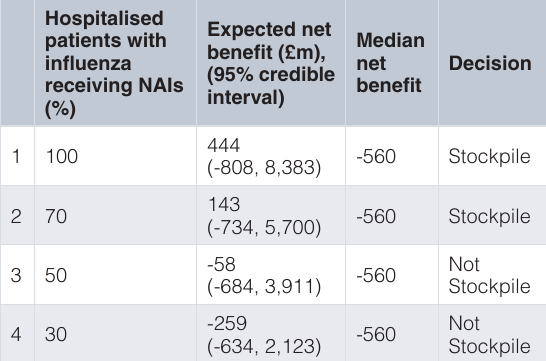
Table 2. Results from baseline analysis and secondary analysis varying the proportion of hospitalised cases receiving NAIs.